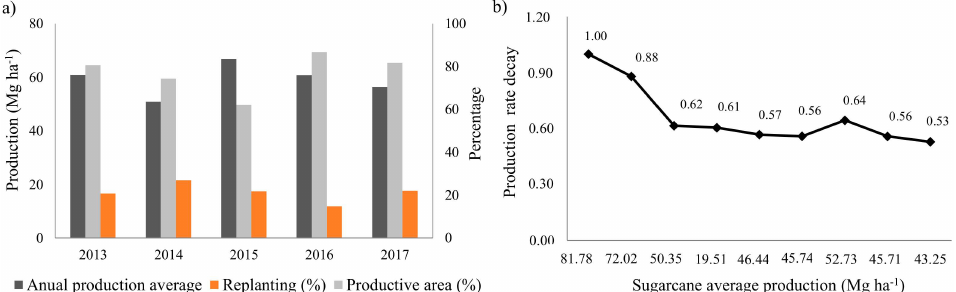
Figure 11. ( a ) Yield production areas from 2013 to 2017 with an average annual production consider- ing all sugarcane cycles and the replanting areas. ( b ) The average yield in nine sugarcane crop cycle with production rate